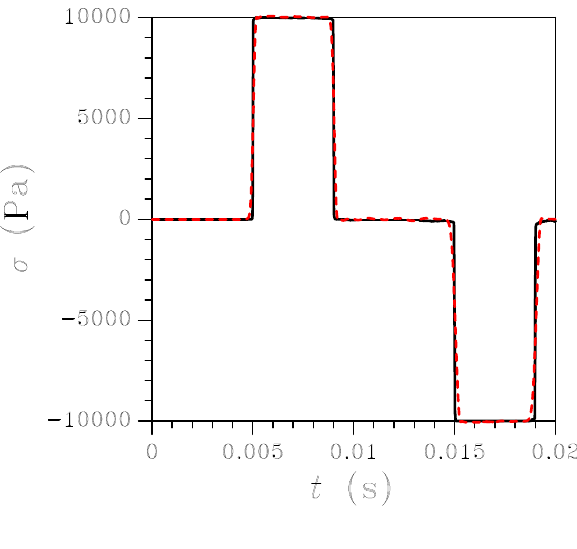
Figure 9. Wave propagating along a homogeneous rod discretized with unstructured meshes: comparison between the evolutions of the longitudinal stress at x = 0 . 5 m, as obtained through one-dimensional (black solid line) and two-dimensional (red dashed line) simula- tions.